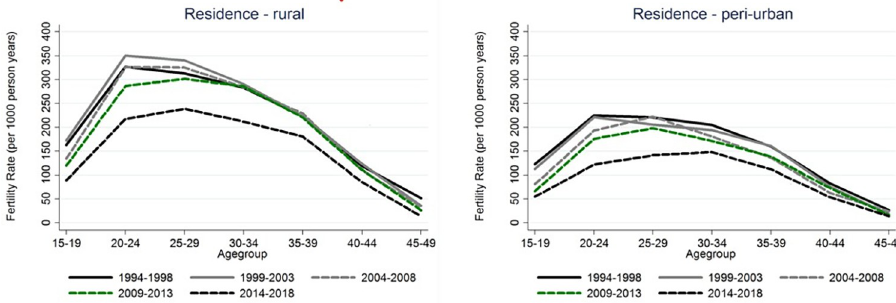
Fig 3. ASFR trends by place of place residence. ASFR by Calendar years (Rural), ASFR by Calendar years